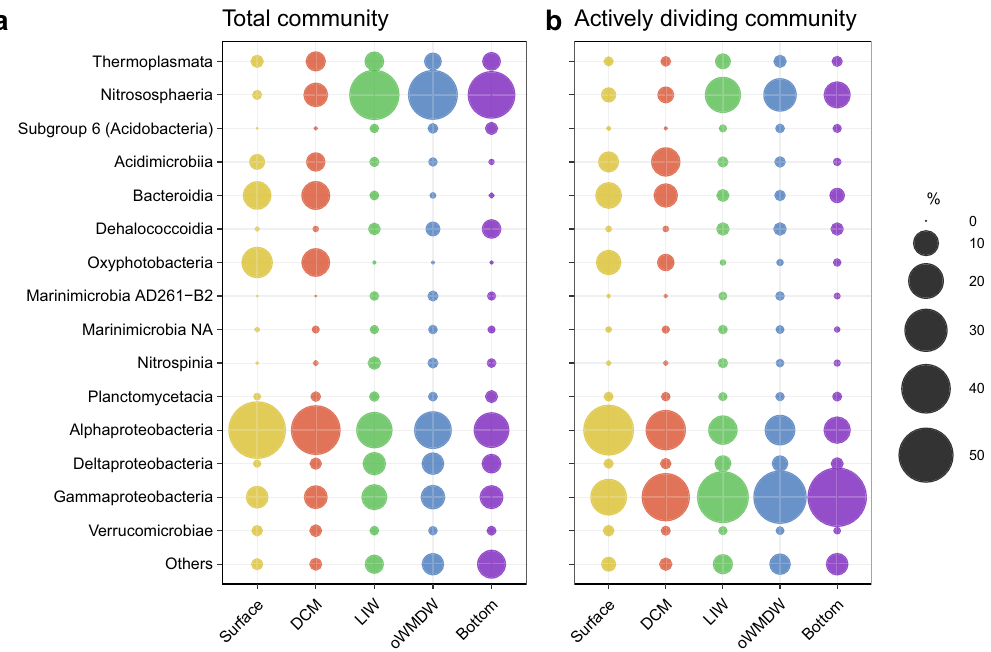
Figure 2. Contribution of phylotypes to ( a ) total and ( b ) actively dividing communities in different depth layers. Bubbles show the relative abundance of taxa at the Class level. Taxa contributing ≤ 0.5% of abundance in total and/or actively dividing communities are combined in ‘Others’ group. DCM: deep chlorophyll maximum; LIW: Levantine intermediate water; oWMDW: old western Mediterranean deep water; NA: